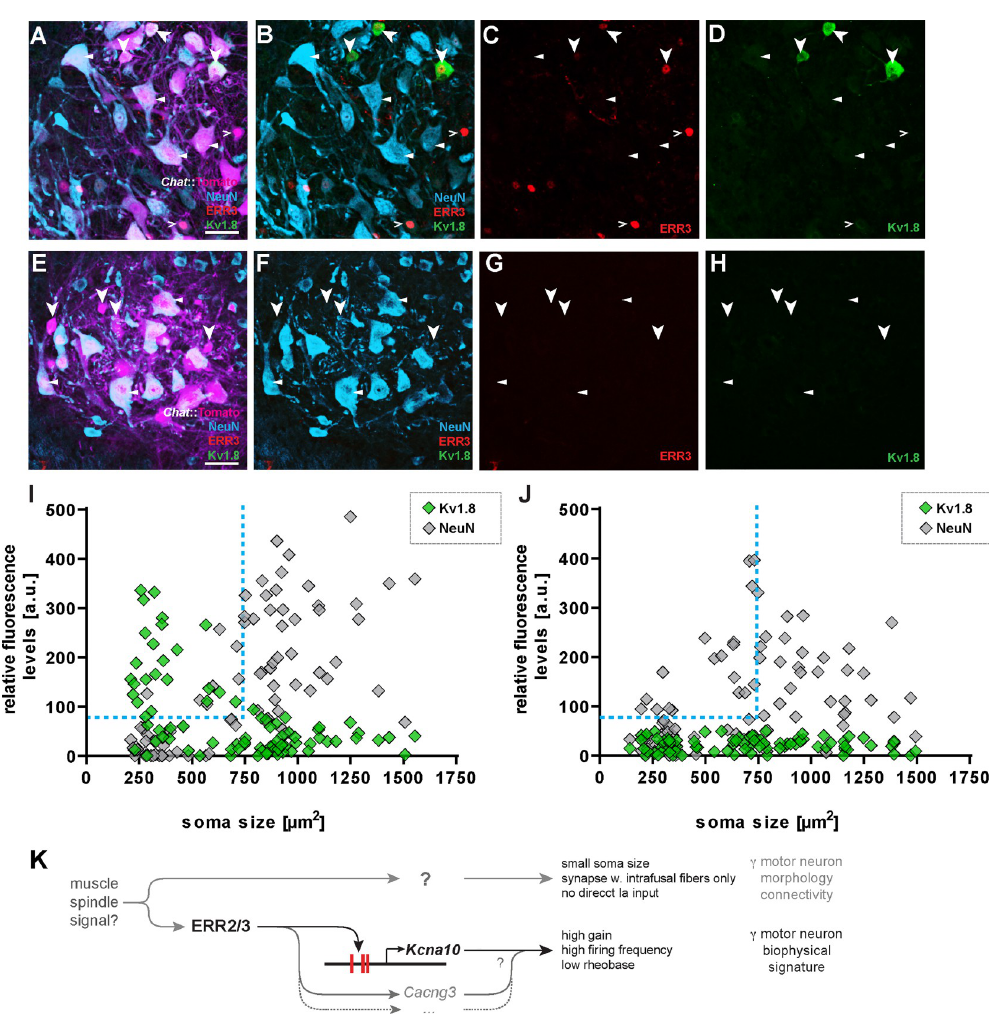
in small ERR3 high NeuN low tdTomato + motor neurons. Triangles: low or not-detectable Kv1.8 levels in ERR3 low NeuN high tdTomato + motor neurons. Open arrowheads: some ERR3 high NeuN low tdTomato + motor neurons possess low or not- detectable Kv1.8 levels. (E-H) Loss of detectable Kv1.8 levels in NeuN low tdTomato + motor neurons (arrowheads) in ERR2/ 3 cko mice. (I) Two-dimensional scatter plot of relative fluorescence intensities over soma sizes: high Kv1.8 levels in NeuN low motor neurons with small somas and low Kv1.8 levels in NeuN high motor neurons with larger somas in control mice ( n = 84, N = 3). (J) Loss of high Kv1.8 levels in NeuN low motor neurons with smaller somas in ERR2/3 cko mice ( n = 84, N = 4). (K) Summary: ERR2/3 promote a gamma motor neuron biophysical signature required for spindle-dependent proprioceptive movement control, possibly by operating through the activation of neural activity modulator genes including Kcna10 (and likely others), while the generation of morphologically distinguishable gamma motor neurons proper may involve other factors operating earlier in development. n : number of neurons, N : number of mice. Data for Fig 8I and 8J can be found in S2